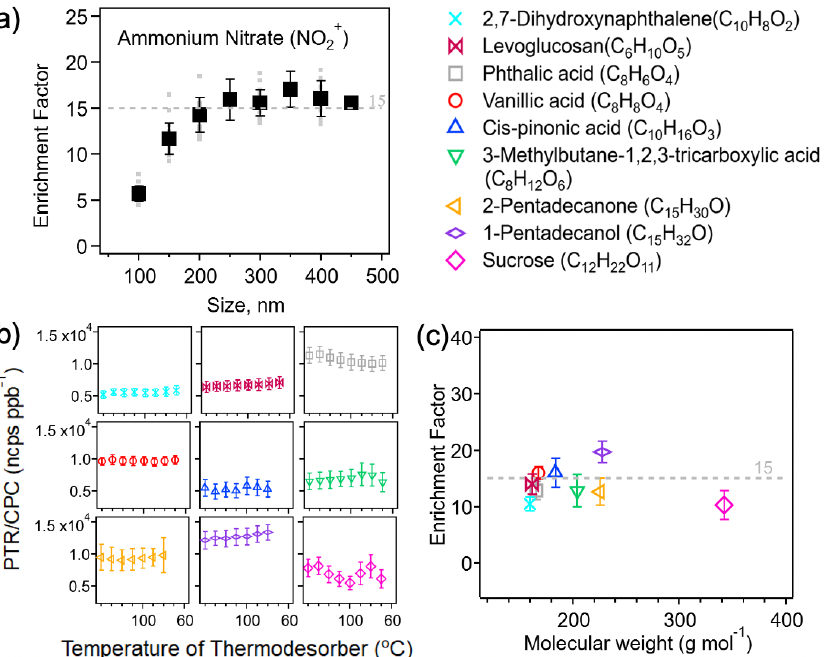
Figure 1. (a) Measured unitless enrichment factor (EF) of ammonium nitrate particles as a function of particle size in the 100–450nm range. Grey markers represent all replicating measurements. The error bar denotes 1 standard deviation (1 σ) of the average. (b) Ratios of PTR- ToF-MS signals (including both parent and fragment ions) to CPC counts ( ± 1 σ ) at 300nm for all organic standards studied. (c) EF ( ± 1 σ ) of selected organic standards based on the calculated